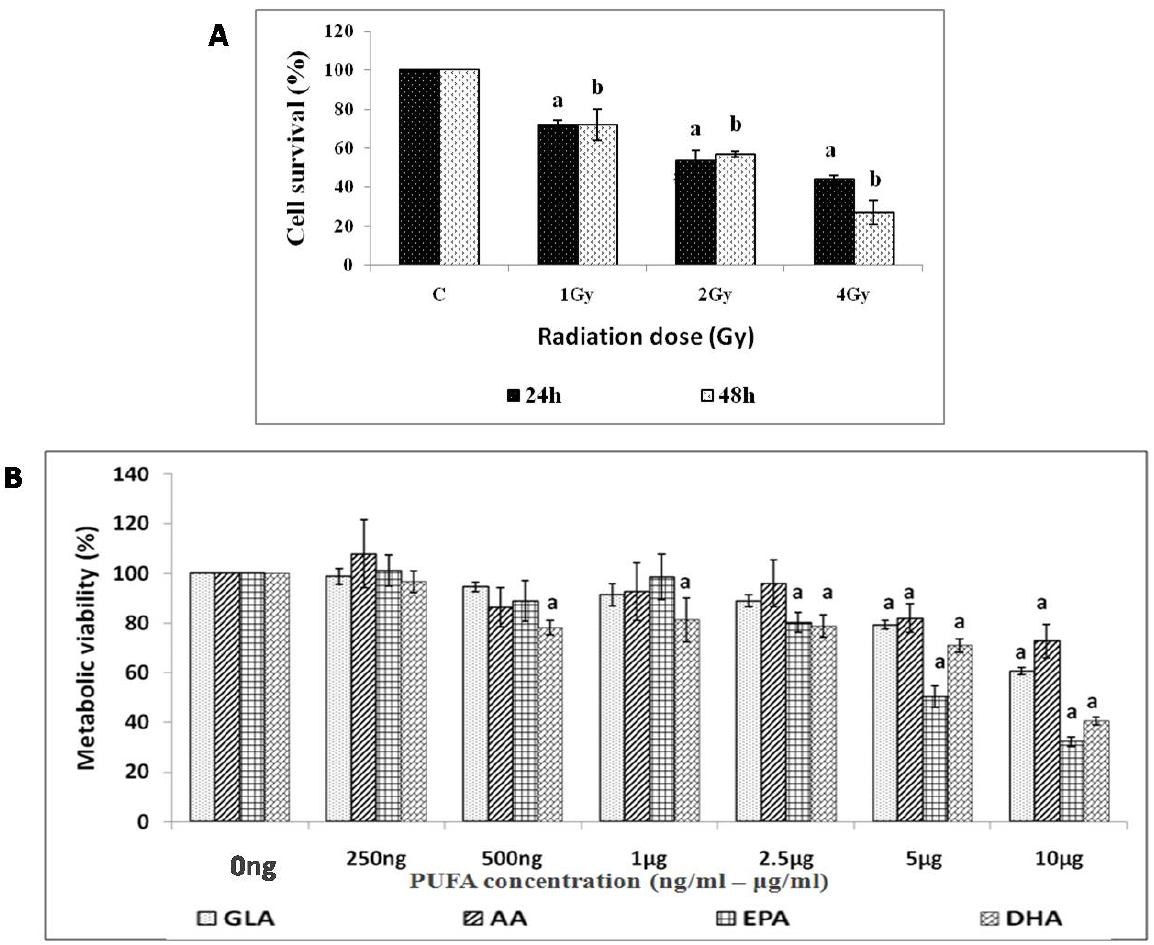
Figure 2. ( A ). Effect of ionizing radiation on the viability of RAW 264.7 cells as assessed by trypan blue dye exclusion method. Values (n = 6) expressed as mean ± SEM. a ( p < 0.05) represents significant decrease in %Survival when compared with control at 24 h. b ( p < 0.05) represents significant decrease in %Survival when compared with control at 48 h. ( B ). Study of effect of PUFAs, GLA, AA, EPA, and DHA, on the viability of RAW 264.7 cells by MTT assay. Values (n = 6) expressed as mean ± SEM. a ( p < 0.05) represents significant decrease in %Survival when compared with control at 24 h. GLA, gamma-linolenic acid; AA, arachidonic acid; EPA, eicosapentaenoic acid; DHA, docosahexaenoic acid.